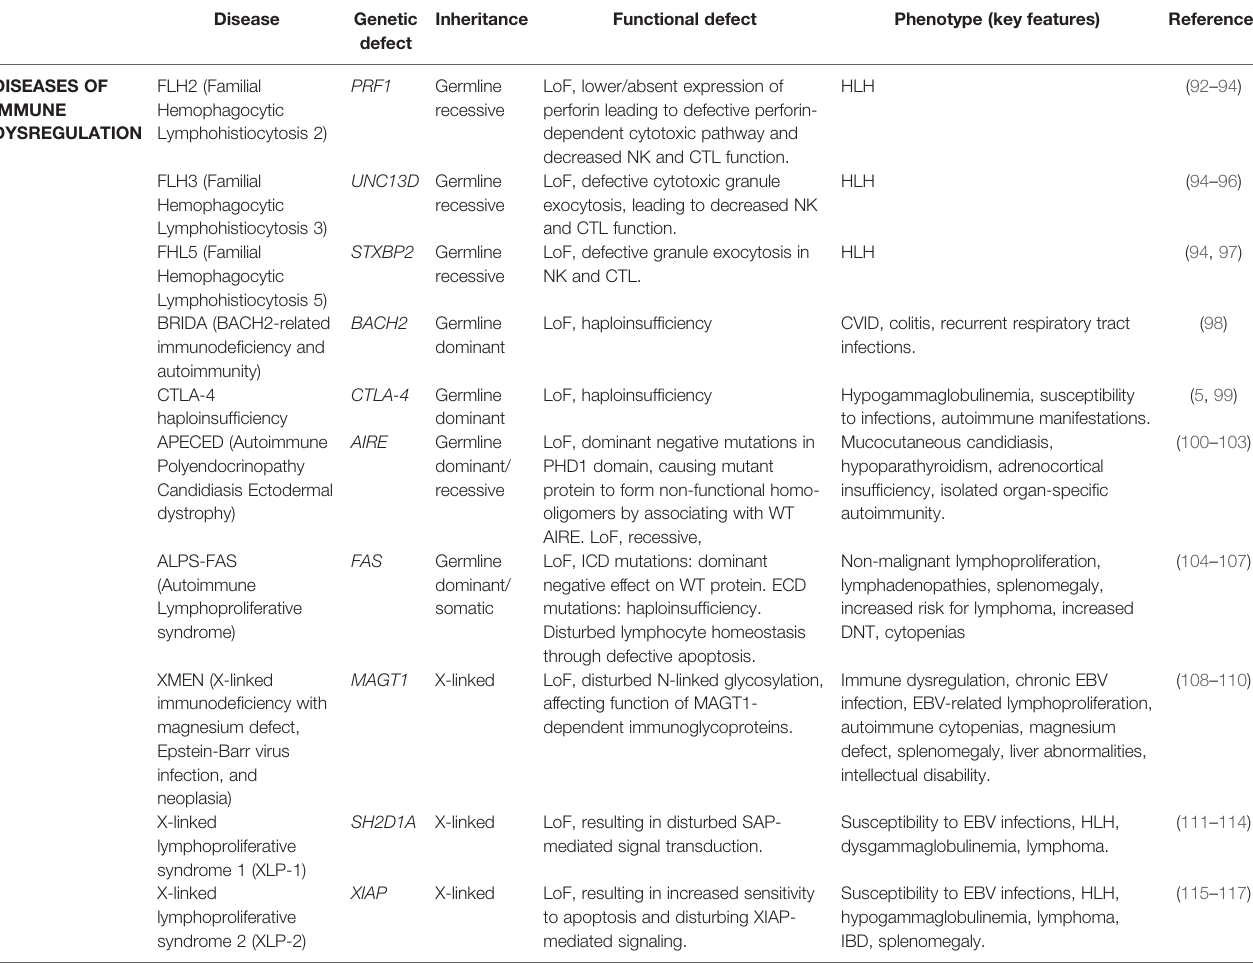
TABLE 4 | Genes associated with adult-onset diseases of immune